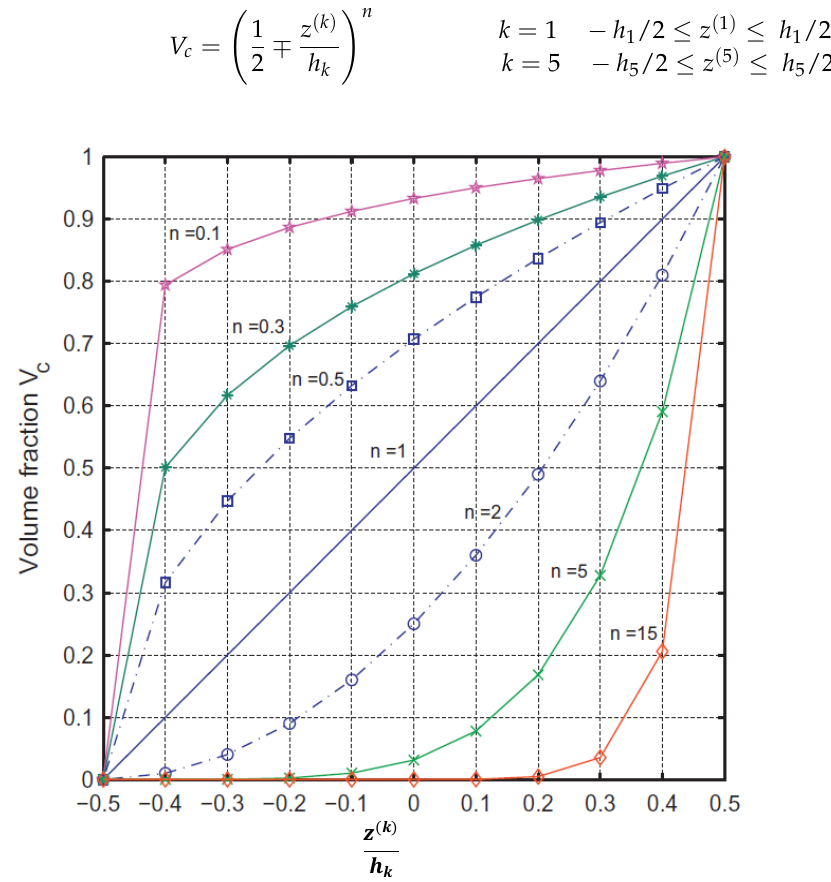
Figure 1. Variation of volume fraction against the non ‐ dimensional thickness [2].